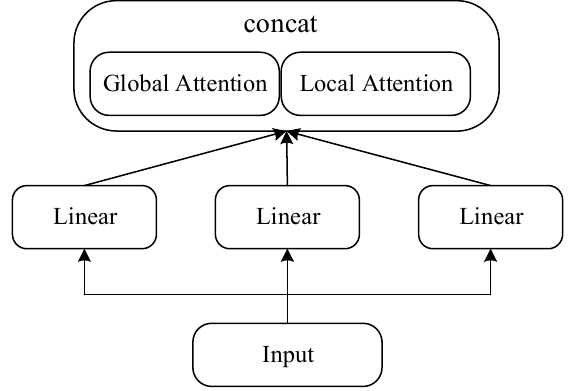
Figure 6. Parameter reduction diagram. Table 5. Experiment results of parameter reduction.